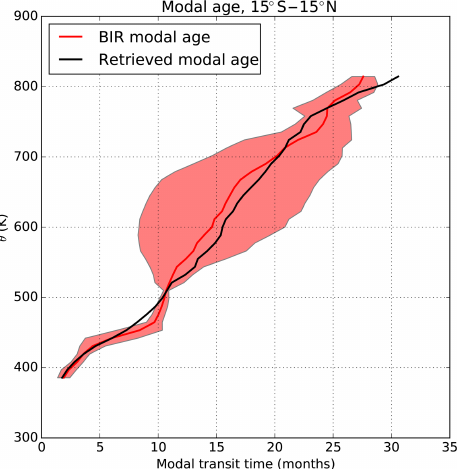
Figure 6. Profile of tropical (15 ◦ S–15 ◦ N) modal age on 31 De- cember 1983 in the CLaMS simulation, determined using the BIR method (red) or retrieved using the procedure highlighted in Sect. 3 (black). The red shading corresponds to ± the standard deviation of the mode of the BIR spectrum in the 15 ◦ S–15 ◦ N region and is introduced to guide the eye regarding the range of